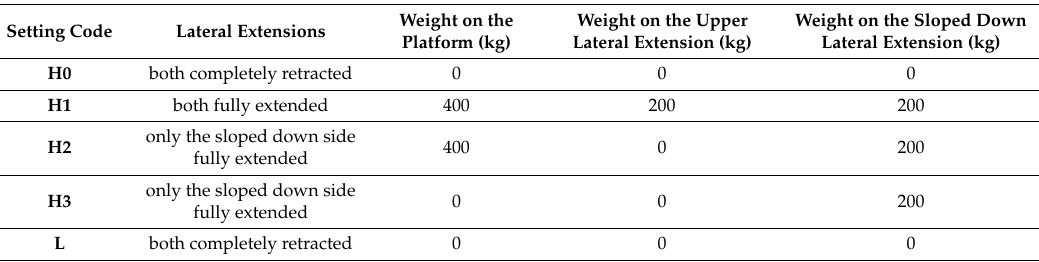
Figure 4. The double weight method (standing on the four wheels and with a 20 ◦ inclination) was adopted for the assessment of the centre of gravity. Table 4. Settings of the SPFHs during the CoG determination.